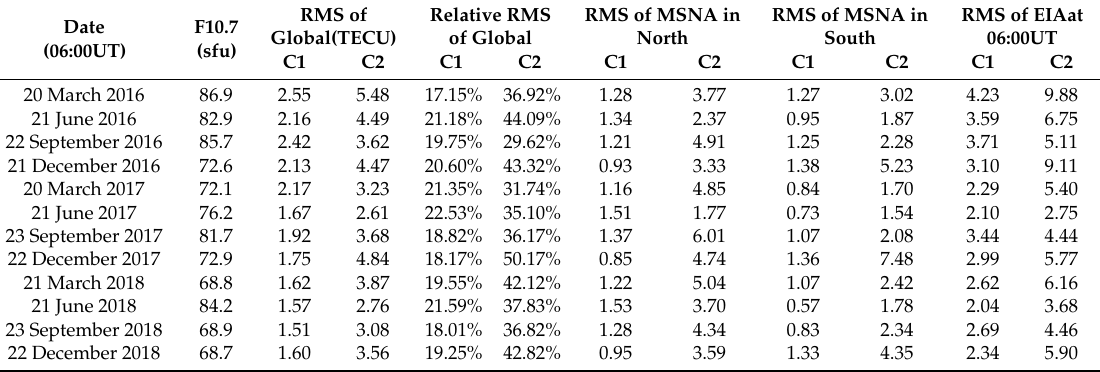
Table 3. RMS Statistics of difference between CODE GIM and models (TECM-GIRD and NTCM-GL). Date F10.7 (06:00UT)